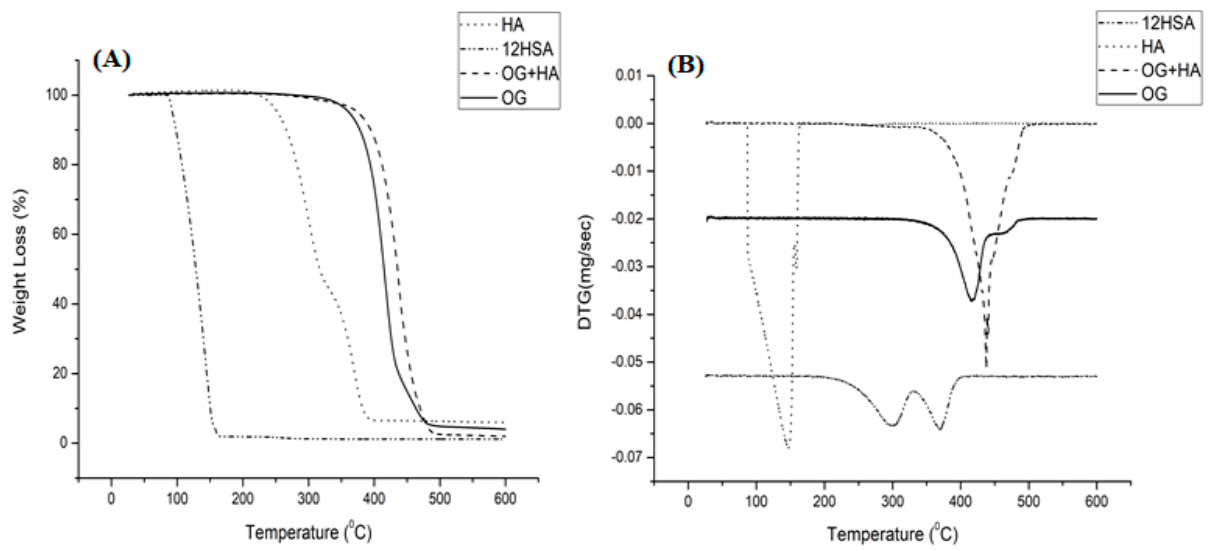
Figure 3. TG ( A ) DTG ( B ) curve of HA, 12HT, OG and OG + HA in N 2 atmosphere (50 mL/min) and 10 °C/min heating, in a temperature range from 25 to 600 °C.